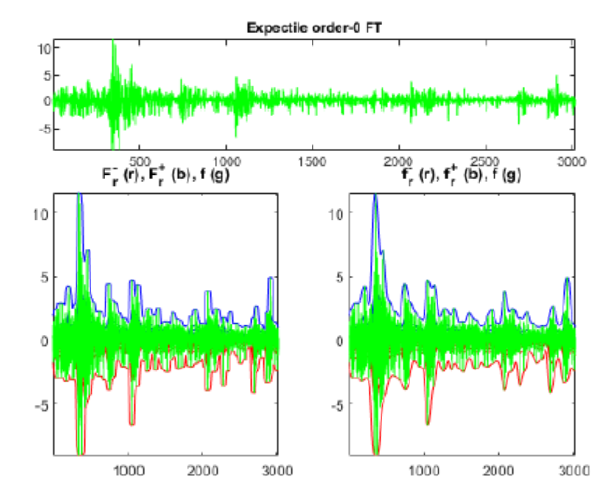
Figure 5. Graphical representation of the minimizers in Equation (2) when developing Figure 5: Graphical representation of the minimizers in equation (2) when de- expectile smoothing. veloping expectile smoothing.